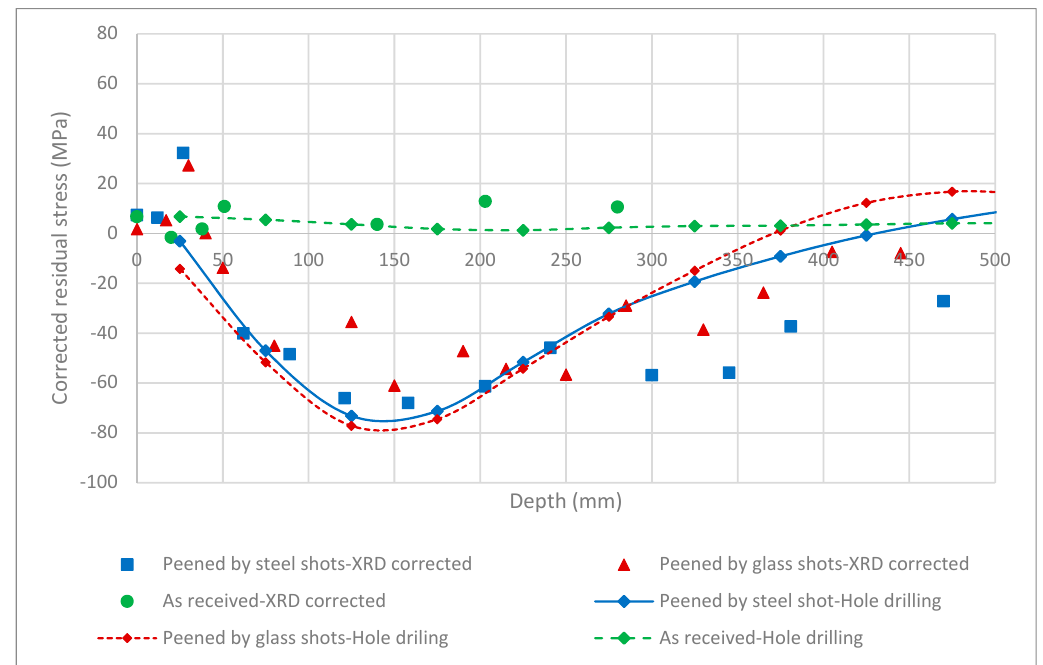
Figure 8. Residual stress distribution of the as-received, peened with steel shot, and peened with glass shot samples, as measured by the hole drilling method. Corrected residual stress measurements of XRD are added for comparison to show close agreement of the results.